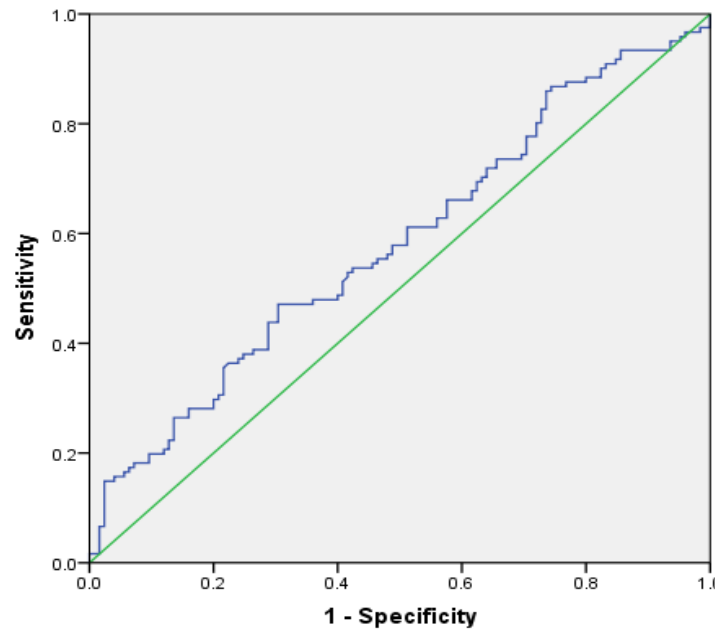
Figure 1. Receiver–operating characteristics (ROC) curve analysis for monocyte to lymphocyte ratio as a predictor of the severity of diabetic